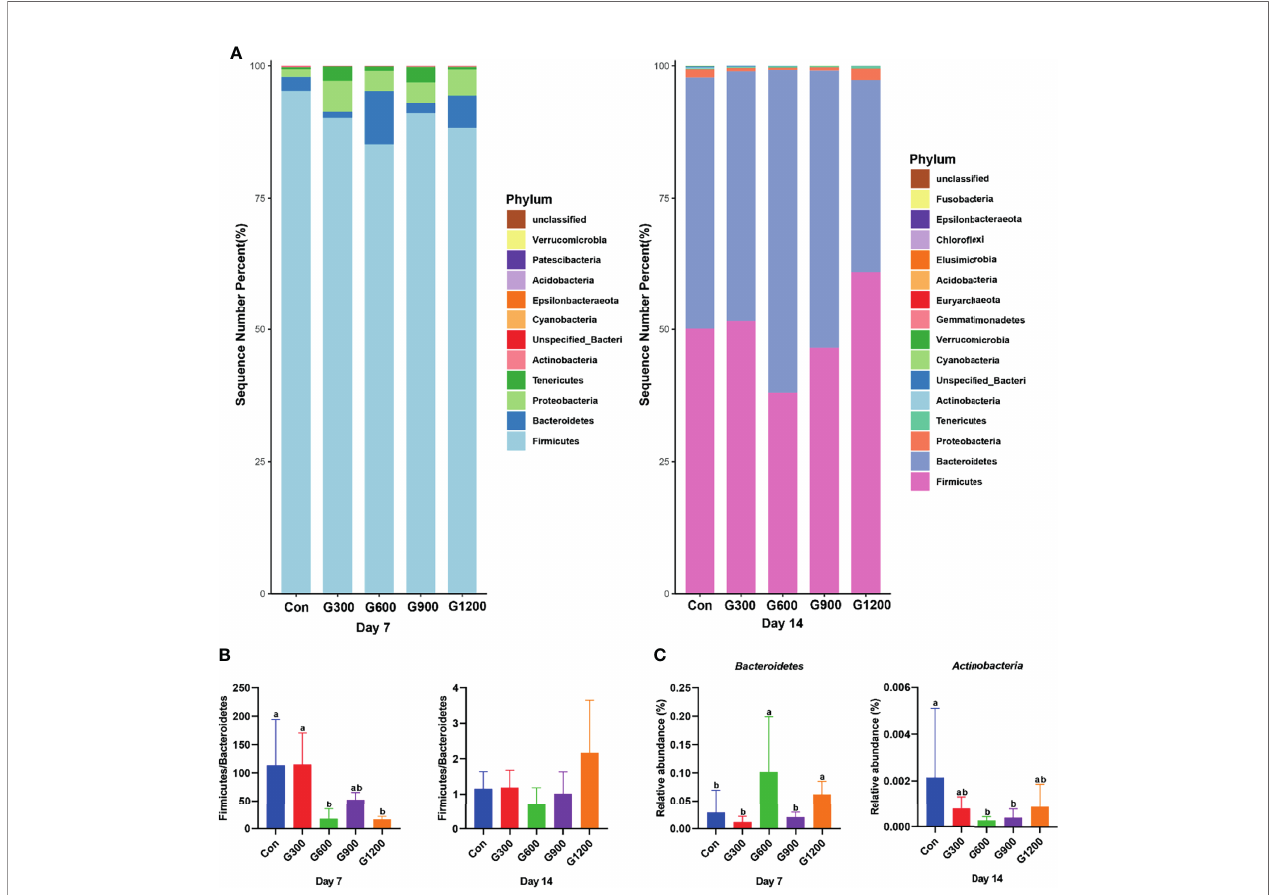
FIGURE 2 | Alteration of cecal microbiota on the phylum level. (A) The top 20 phyla in the relative abundance of each group. (B) The ratio of Firmicutes/ Bacteroidetes. (C) Relative abundance of Bacteroidetes and Actinobacteria . Different superscripts indicate signi fi cant differences according to the Kruskal-Wallis test ( P < 0.05). Con, basal diet; G300, 600, 900, and 1200, basal diets complemented with 300, 600, 900, or 1200 mg/kg